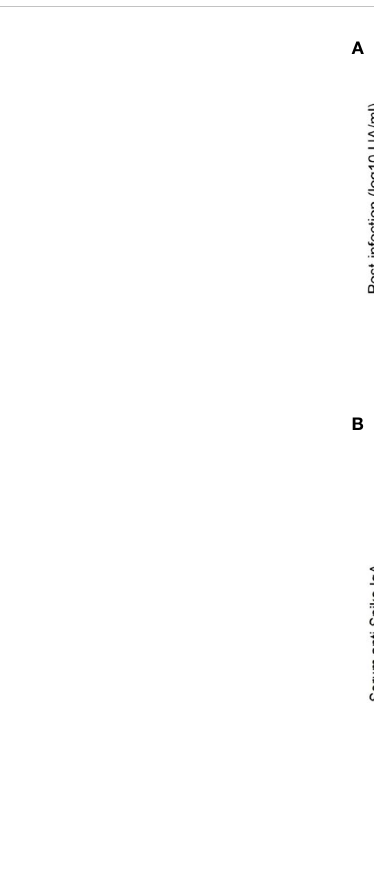
FIGURE 7 SARS-CoV-2 vaccination reactivated mucosal immunity in previously infected individuals. (A) Salivary anti-Spike IgA post-immunization (Visit 3) positively correlated with salivary anti-Spike IgA post-infection (Visit 1) in previously infected individuals (Pearson correlation, R 2 = 0.735, p<0.001). (B) After immunization, the correlation between saliva and serum anti-Spike IgA was well differentiated in naive (COVID-, blue) and previously infected (COVID+, red) individuals, underlining the reactivation of mucosal immunity in previously infected individuals only: COVID+ group (Adj R 2 = 0.44, slope = 0.45); COVID- group (Adj R 2 = 0.31, slope = 1),